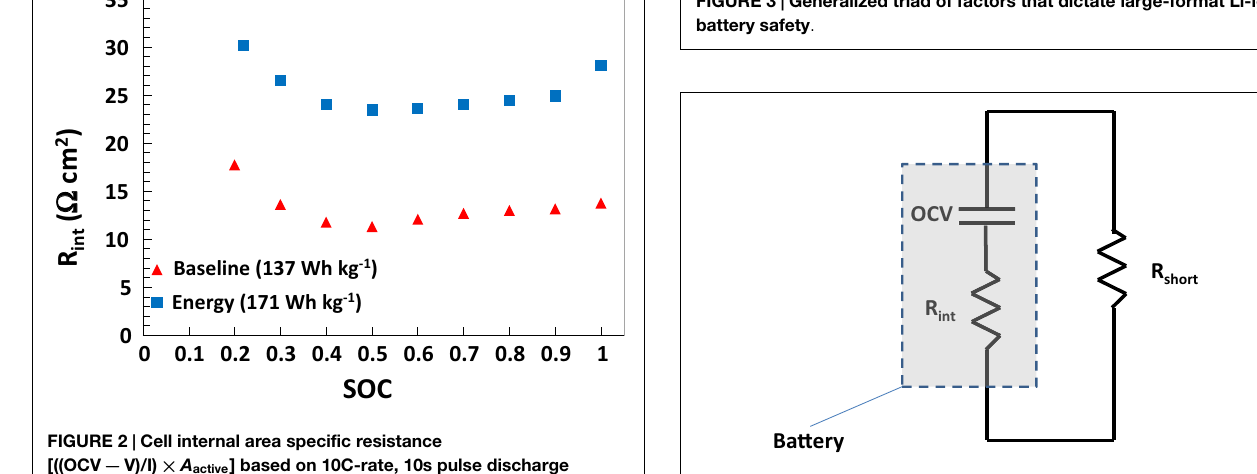
FIGURE 4 | Generalized diagram describing physics of nail shorting process